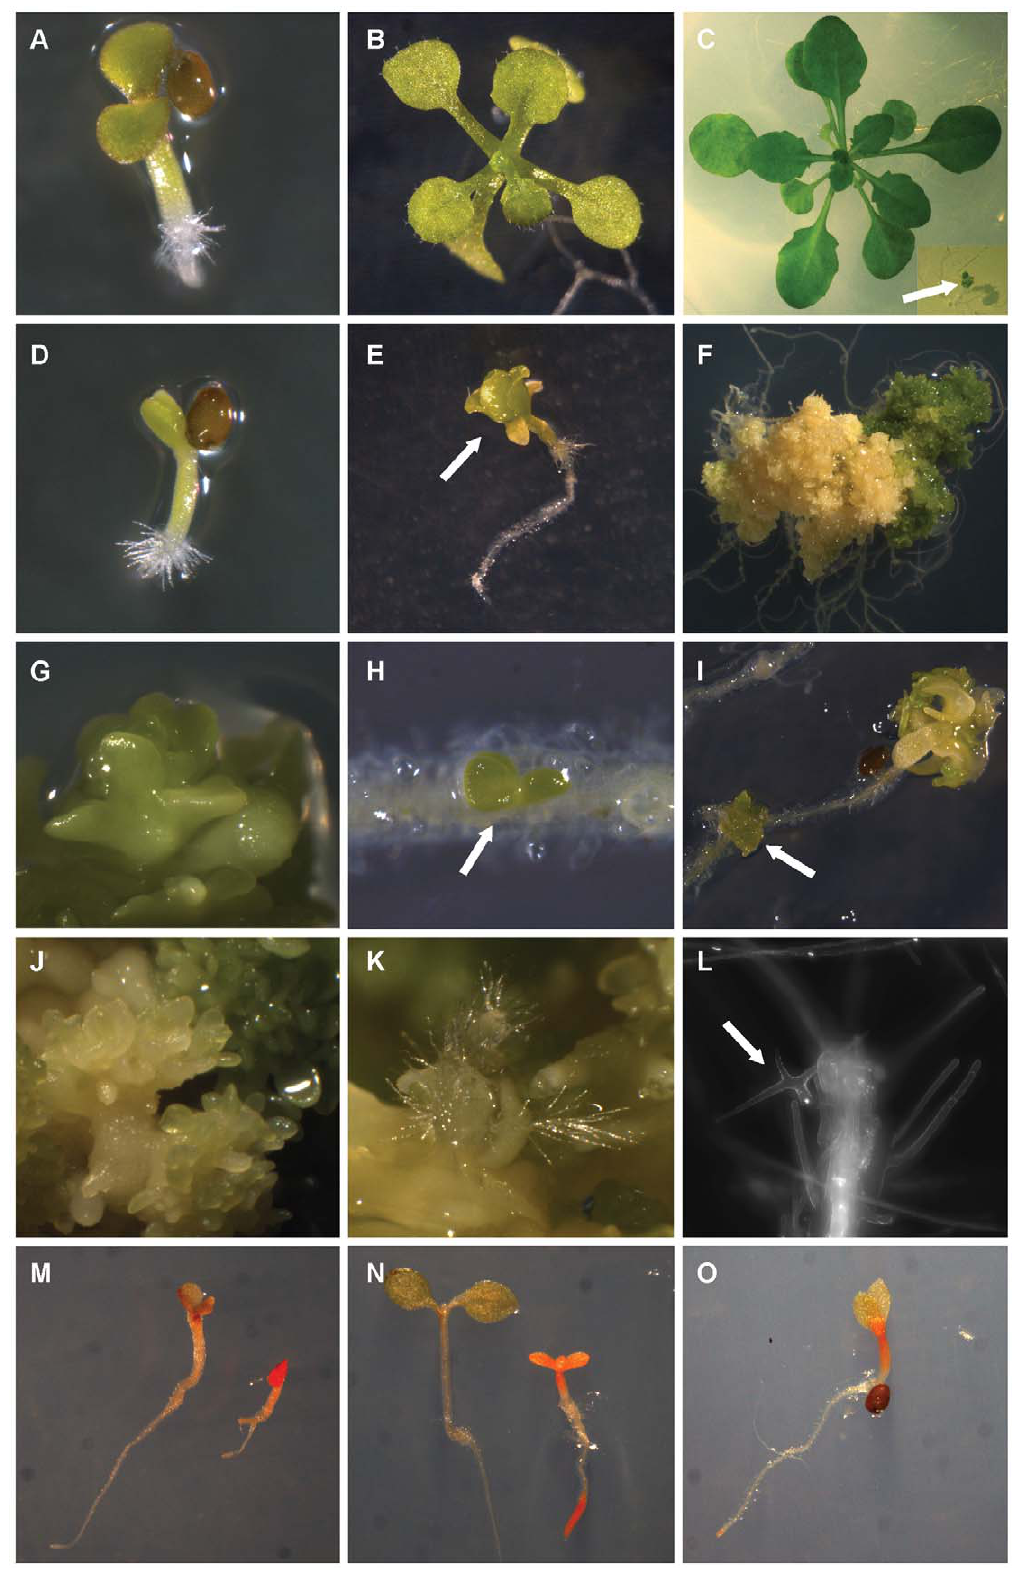
Figure 1. Phenotypic analysis of postembryonic development. Comparison between wild type (A–C) and fie mutant (C–L) development. (A) Wild type seedling at 5 DAS. (D) fie mutants resemble wild type plants at 5 DAS besides a reduction in growth. (B) Wild-type seedlings are in a vegetative phase at 15 DAS and under day-neutral growth conditions will start to bolt when one month old in contrast to (E) fie mutants that show flowers (arrow) already at 15 DAS. (C) Vegetative growth leads to major increase in size of a wild-type plant (left) after 40 DAS whereas a fie mutant